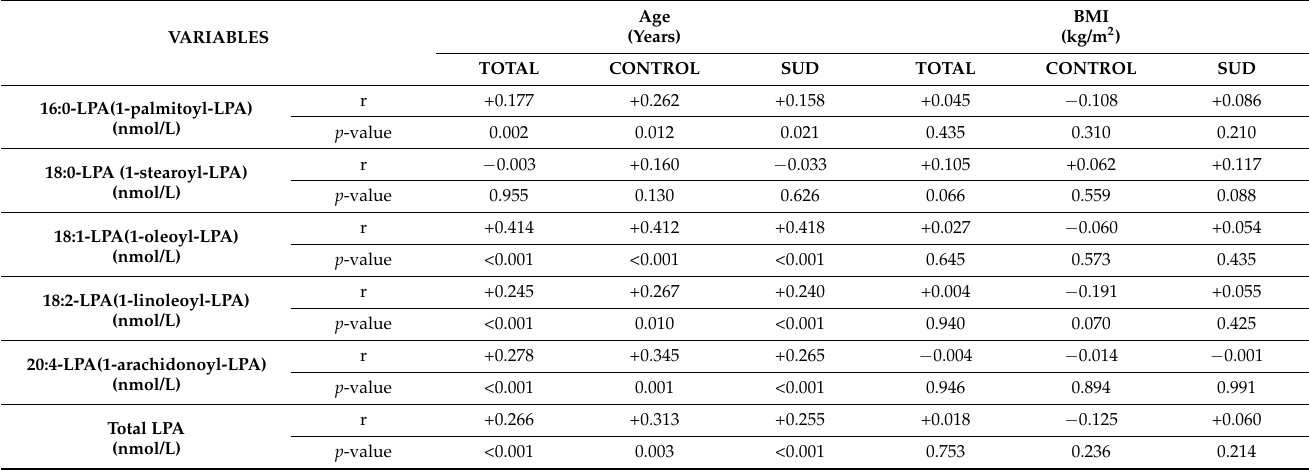
Table 3. Correlation analyses between LPA species and total LPA with age and